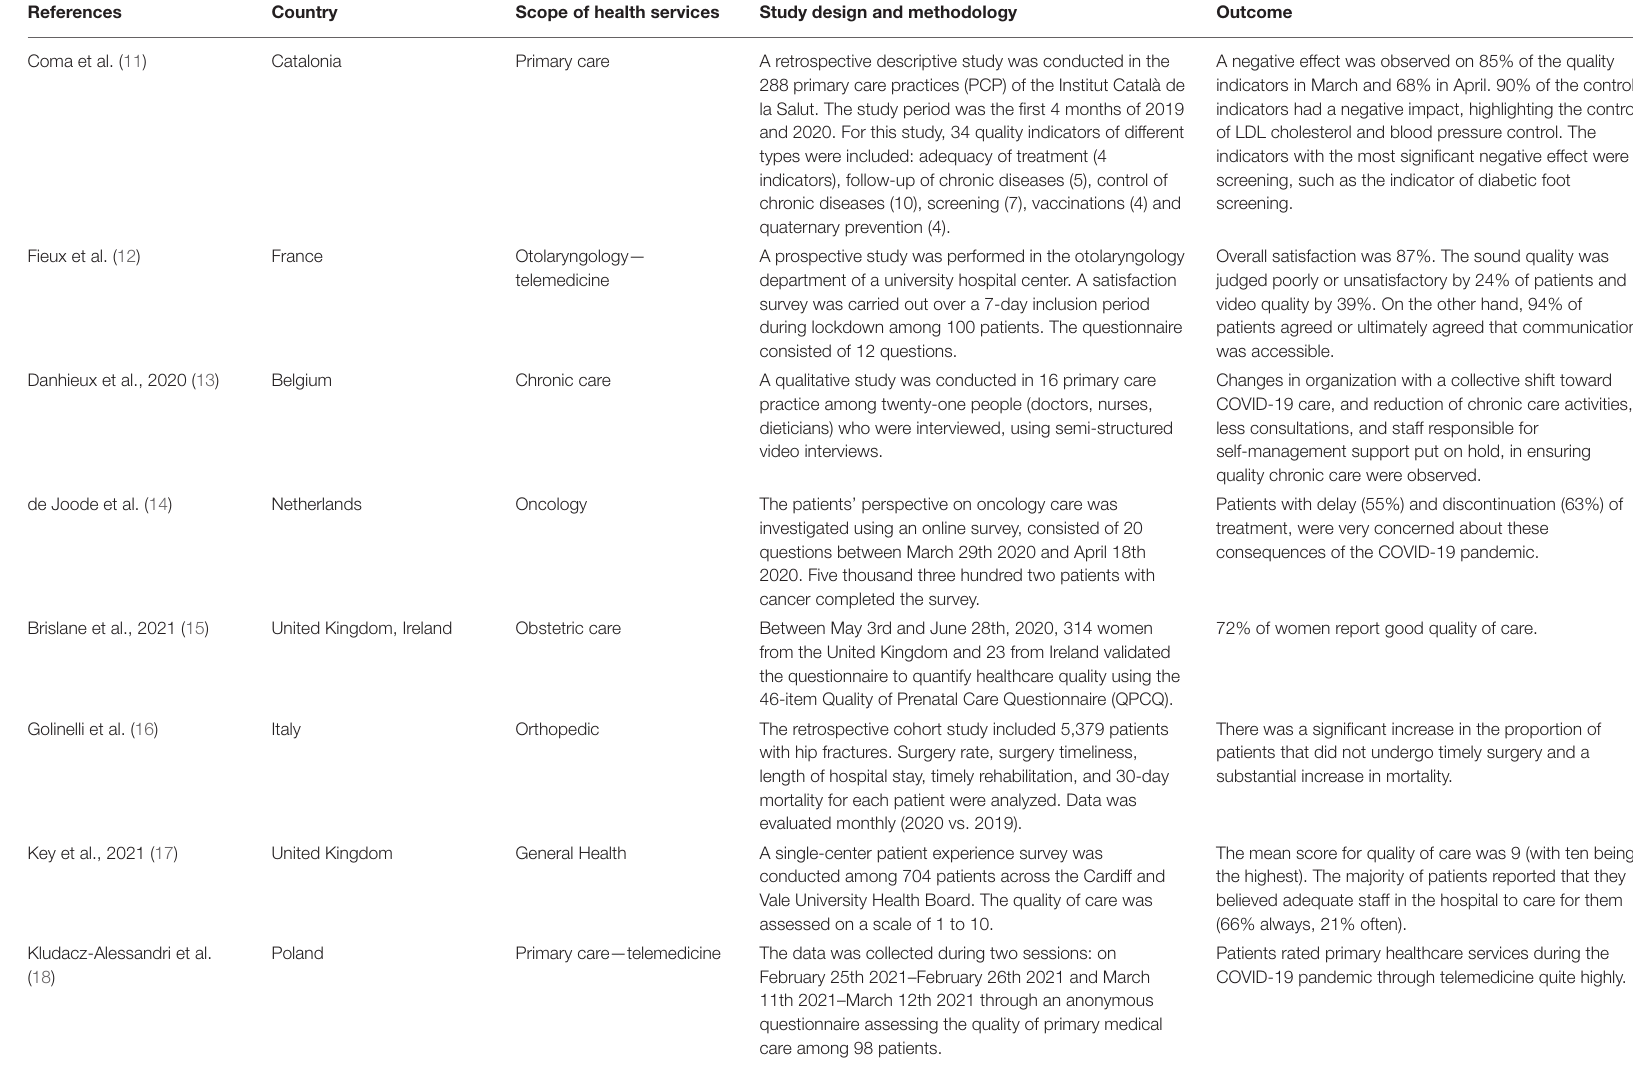
TABLE 1 | An mini overview of studies’ outcomes conducted in Europe regarding to quality of healthcare during